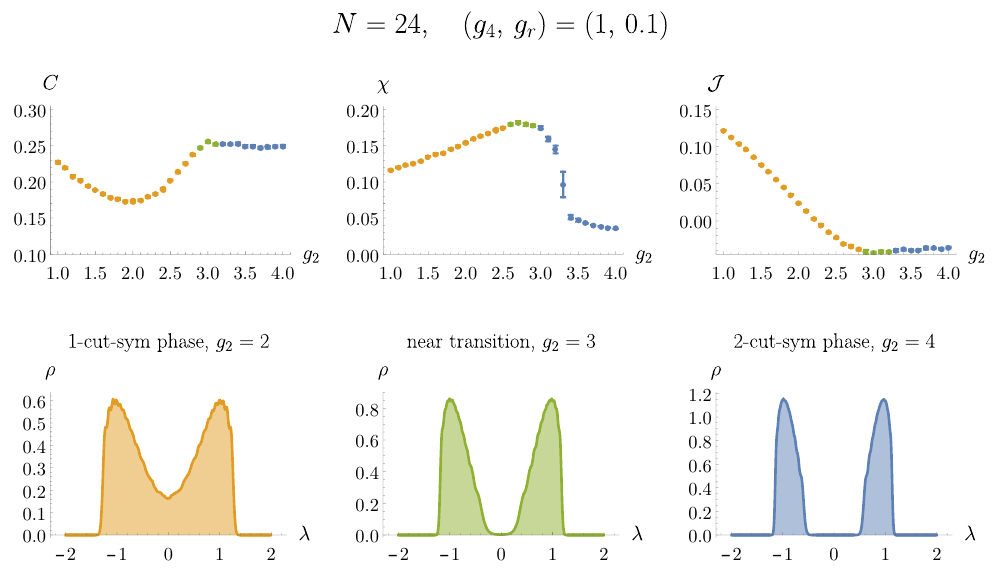
Figure 3 . Transition point detection from peaks and edges of C , χ , and J (top), and from topology change of the eigenvalue-distribution support